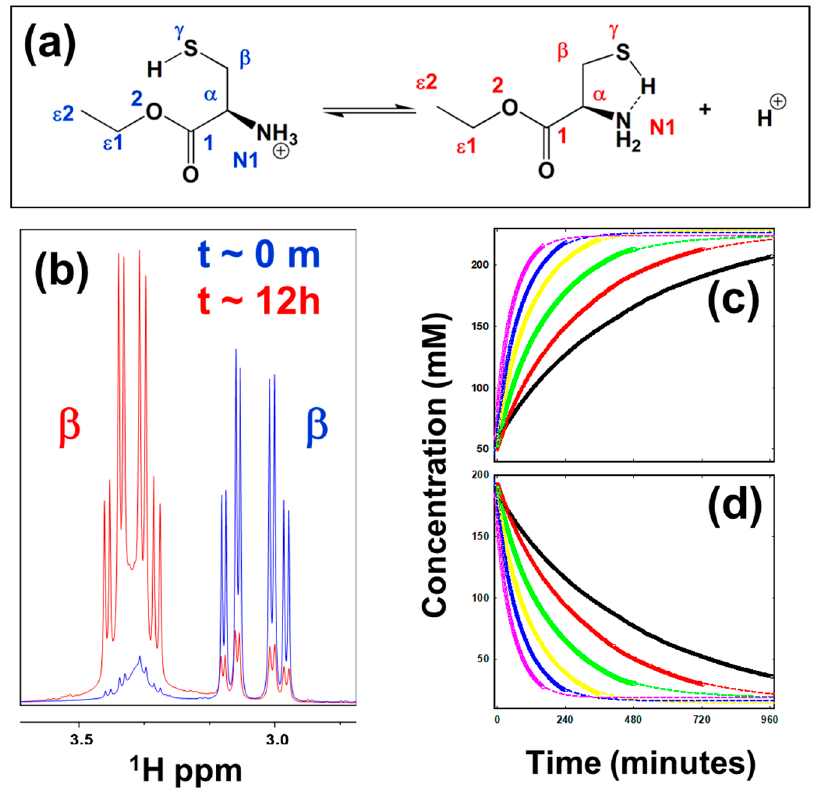
Figure 1. Determination of molecular thermodynamic parameters from the rate of oxidation. ( a ) Structural change due to the oxidation of the thiol proton in the model system L-cysteine ethyl ester ([CysEE-H] +). ( b ) Chemical shift changes due to the oxidation-mediated changes in L-cysteine ethyl ester in the sub-spectral region corresponding to the β -protons of the reactant (blue) and that of the product (red) obtained in dissolving the DMSO-d 6 . The first-order kinetics of the reaction process of L-CysEE at various temperatures are also shown. ( c ) The reduction of the reactant ([CysEE-H] +) measured directly by NMR for various sample temperatures, and the corresponding increase of the ionized product ([CysEE]) ( d ). The experimental measurements are shown as symbols, and the non-linear least square fit to the respective experimental data are shown as dashed lines (samples temperatures are given in the legends). Figure reproduced with permission [24].